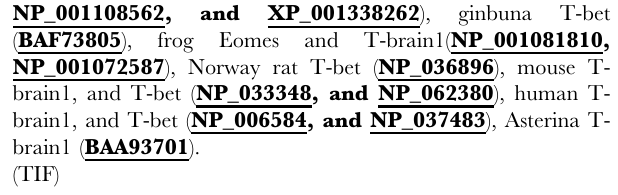
Figure S1 Multiple alignment of Eomes in Atlantic salmon with other vertebrates Eomes. Multiple alignment of the deduced amino acid sequences of Eomes in salmon and other vertebrates by the ClustalW2 program. Residues shaded in black are completely conserved amino acids across all species aligned, and residues shaded in grey refer to 80–90% identity. Dashes indicate gaps. The T-box DNA binding domain is indicated by solid line below the alignment. The GenBank